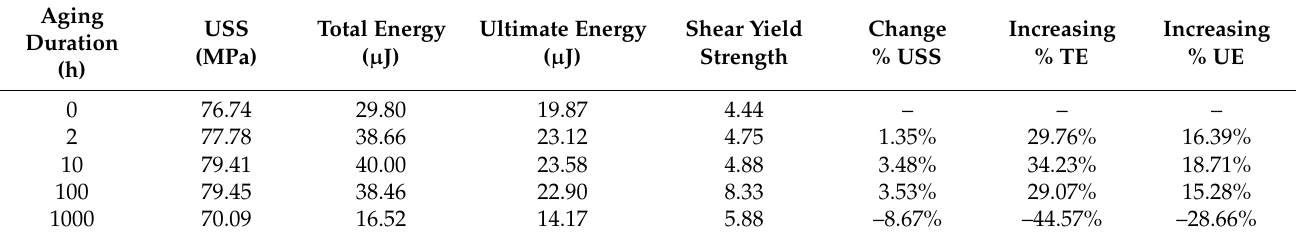
Table 3. Extracted mechanical properties of aged and non-aged Cyclomax.